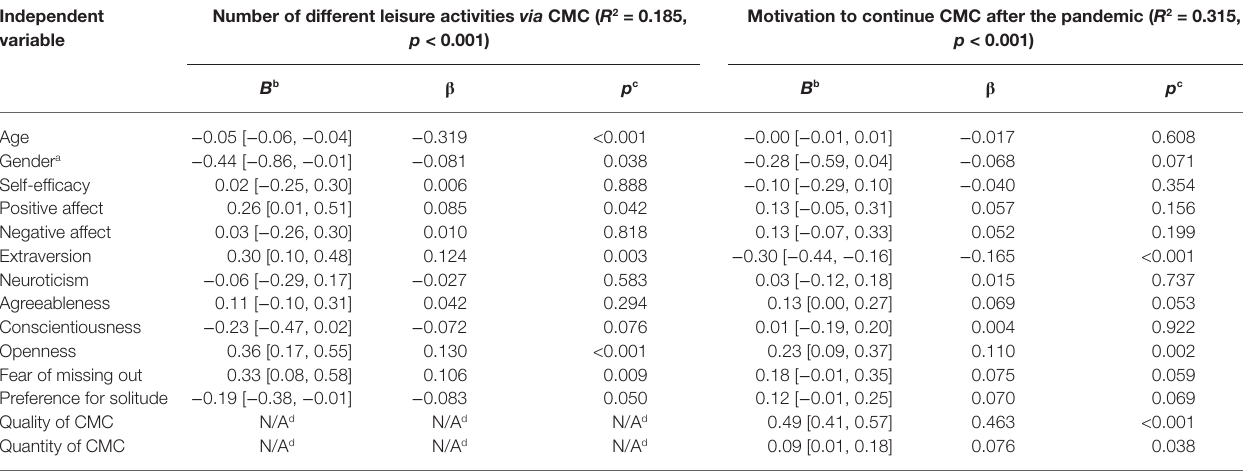
TABLE 2 | Results of the multiple regression analyses. Independent